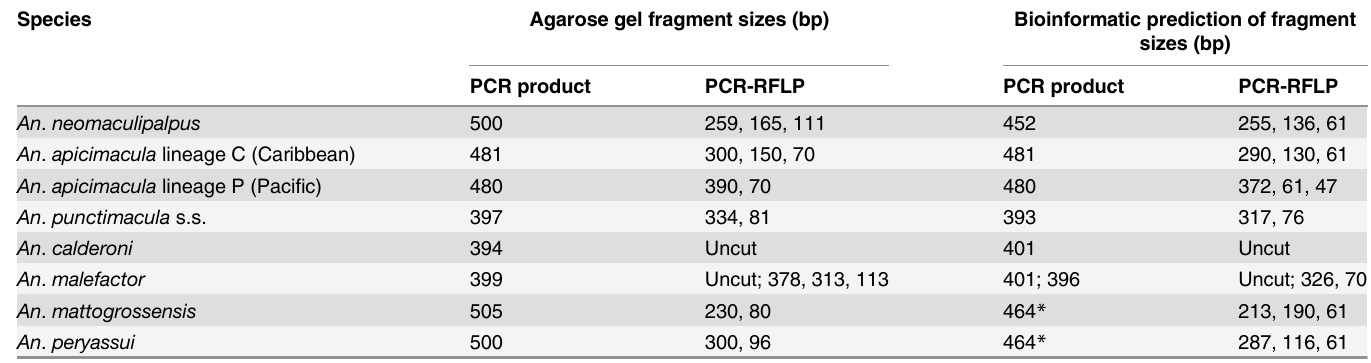
Table 3. Comparison of in vitro with in silico results from PCR-RFLP-ITS2 assay.